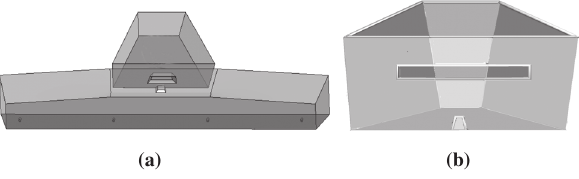
Figure 10: Original tundish: (a) tundish structure and (b) porous baffle